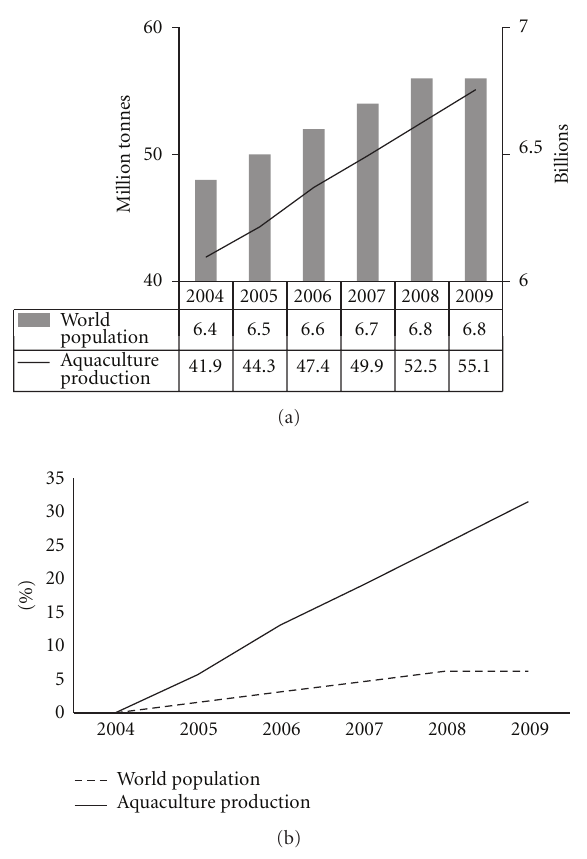
Figure 1: Growth behavior of world population and aquaculture production during the last six years. (a) illustrates the total world population by year (billions) and the total production of aquatic organisms by aquaculture (million tonnes). (b) compares the per- centage of annual increase of world population and aquaculture production, considering year 2004 as the basepoint. Data obtained from FAO Report 2010: World Review of Fisheries and